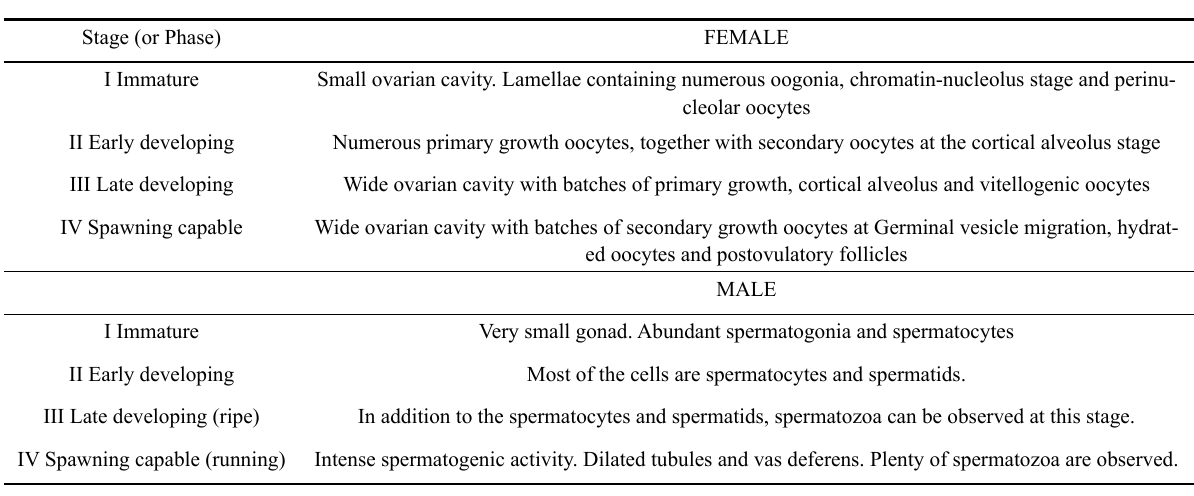
Table 2. – General histological description of developmental gonad stages for females and males of A. minuta, P. ferreri and C. linearis . Stage (or